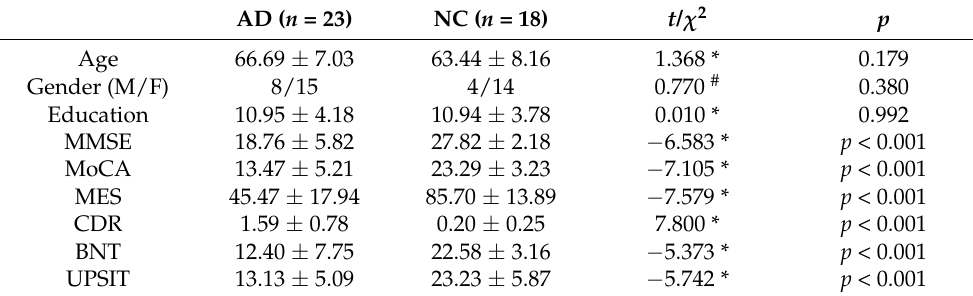
Table 2. Demographic and neuropsychological data of the study participants.